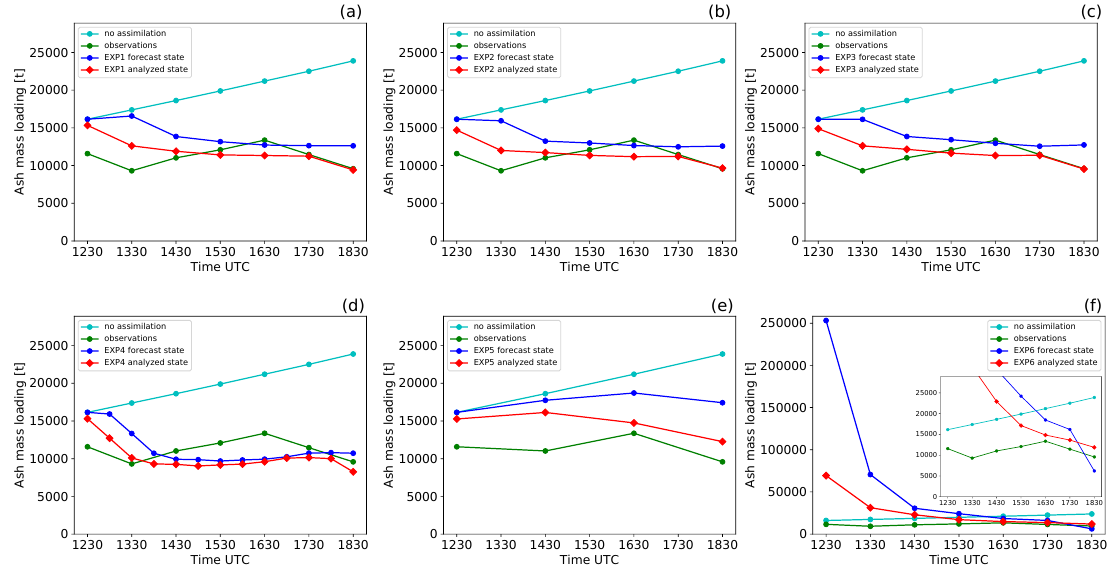
Figure 12. RMSEs computed for observations (green lines), forecast states (blue lines), analyzed states (red lines) and non-assimilated states (cyan lines). Panels ( a – c ) are for EXP1, EXP2 and EXP3. These experiments differ for the angle used to perturb the wind-field (15 ◦ , 10 ◦ and 20 ◦ respectively). Results of EXP4 are shown in Panel ( d ), while results of EXP5 are presented in Panel ( e ). These two experiments present the same input of EXP1, but the observation sampling time is 30 min and 2 h respectively (it was 1 h for EXP1). Finally, results of EXP6 are displayed in Panel ( f ). The inset is a zoom of the RMSEs computed for the first assimilation cycles. EXP6 was initialized with uncertainties on both wind-field and ESPs.